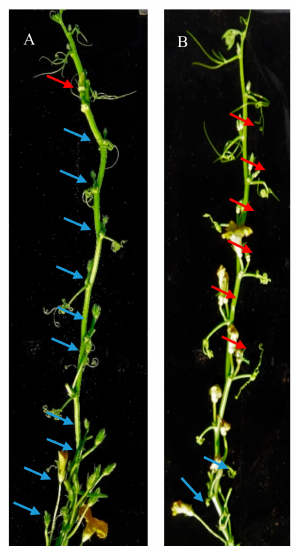
Figure 1. Different flower phenotype of two materials. ( A ) Flower phenotype of ‘9–6’. ( B ) Flower phenotype of ‘2013–12’. ‘9–6’ and ‘2013–12’ produced female flowers 4% and 51% respectively when observed up to node 20 on the main stem. Blue arrows indicated male flowers and red arrows indicated female